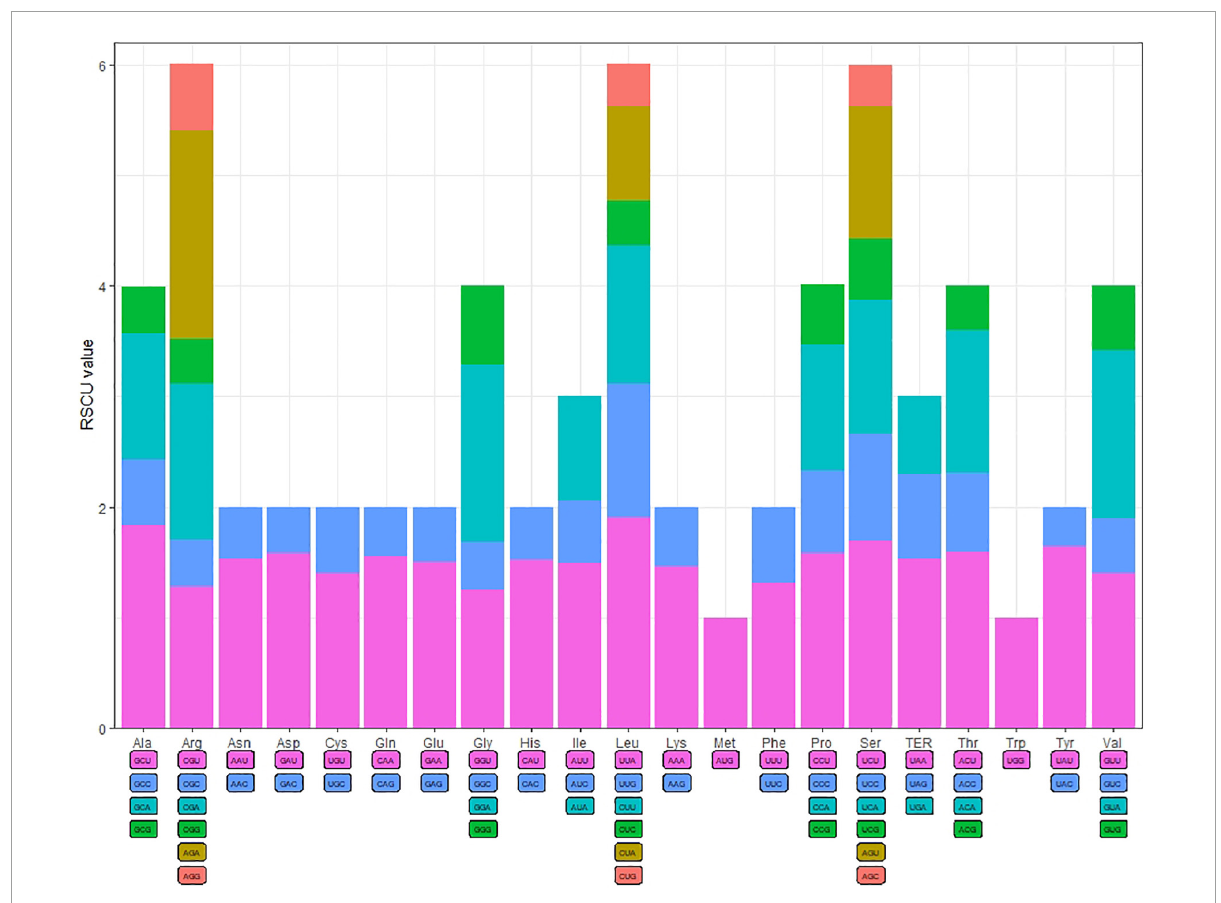
FIGURE2 Codon content and codon usage of 20 amino acids and stop codons in the protein-coding genes of the S. floderusii cp genome.